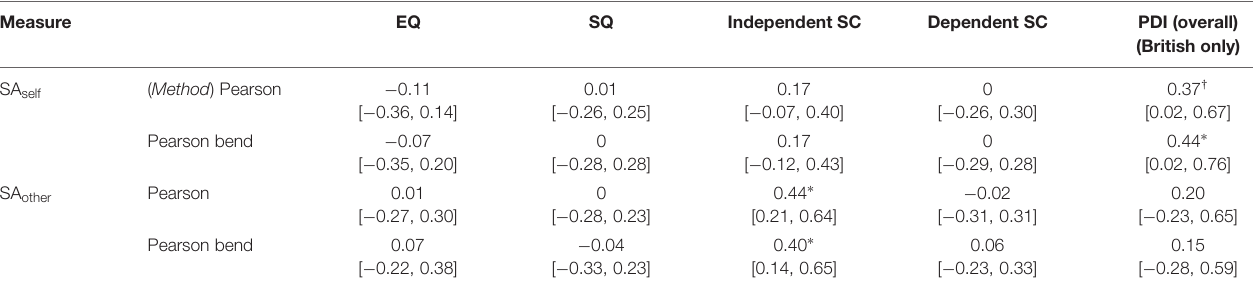
Data shown are Pearson’s r values, and 95% confidence intervals are included in the brackets. Pearson skipped correlations gave similar results. Note that the p-value for the correlation between SA self and PDI overall is just above.05, but the bootstrapped 95% confidence interval is above 0 and Pearson bend correlation was significant. SA self , sensory attenuation for self-generated stimuli; SA other , sensory attenuation for others generated stimuli; EQ, empathy quotient; SQ, systemizing quotient; SC, self-construal; PDI, Peters et al. (2004) delusion inventory. † p = 0.06; ∗ p <